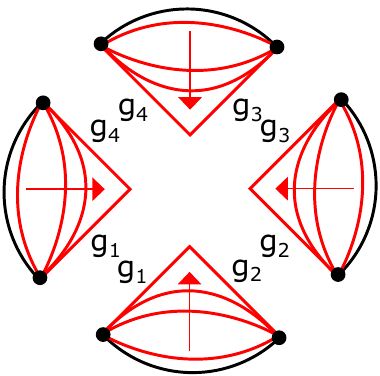
Figure 7 . Hilbert space slicing within each of the wedges. We are interested in the Hilbert space description on the (cid:12)nal slice, consisting of two connected straight